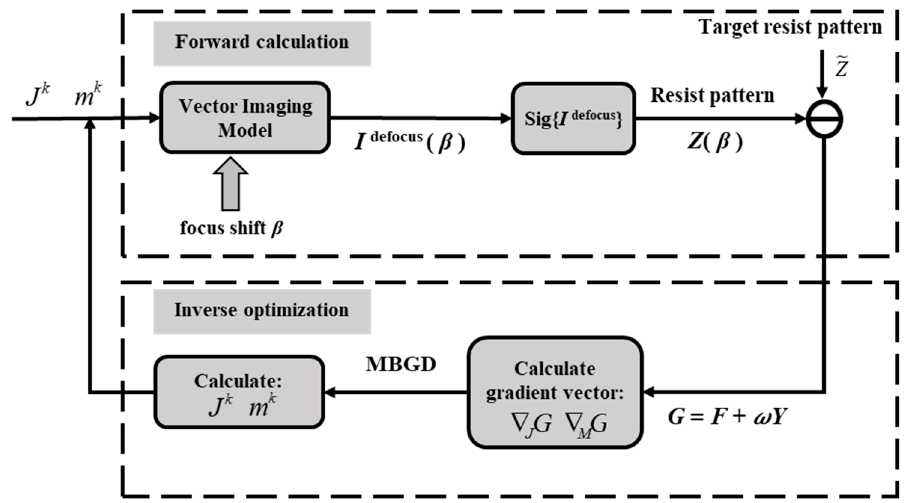
Figure 1. Forward calculation and inverse optimization process for defocus robust SMO ( DRSMO ).